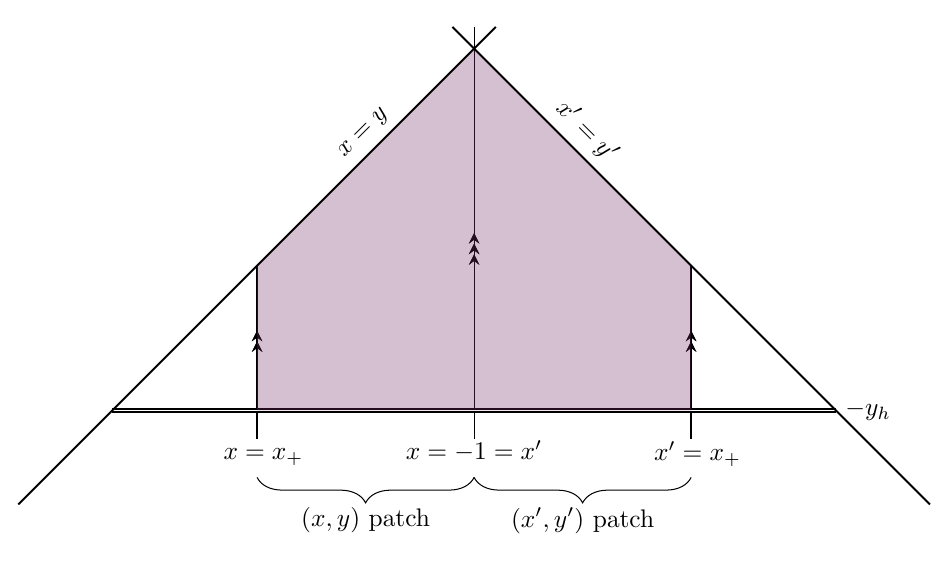
Figure 17 . The two patches of type II spacetime used to construct a black hole with a pulling